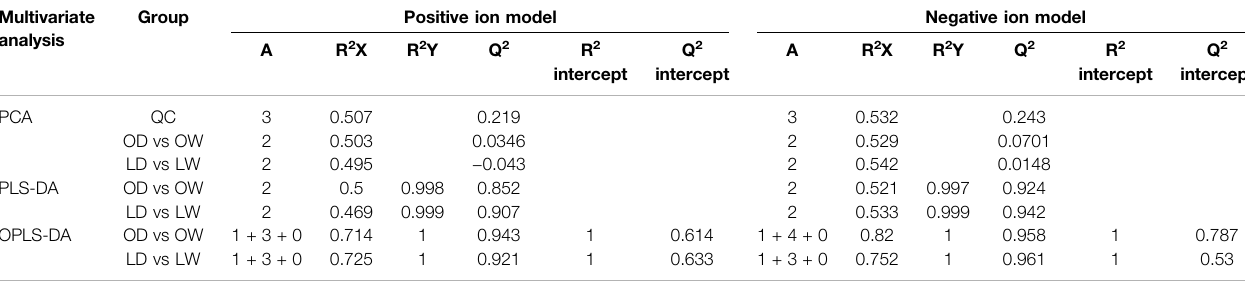
TABLE 1 | Multivariate analysis of metabolites in wild and captive-reared S. o ’ connori . Multivariate Group analysis